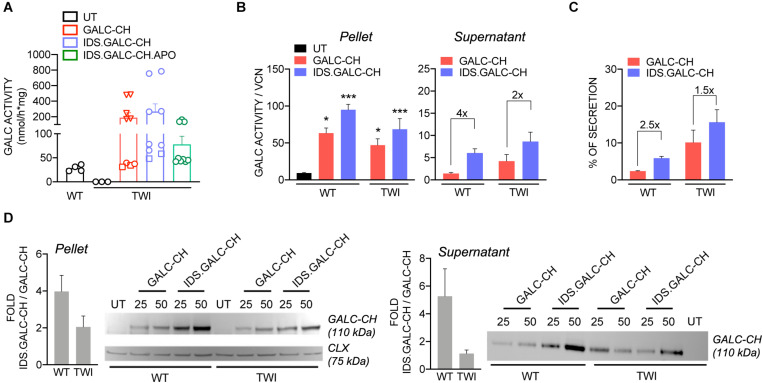
LV-transduced NPCs and progeny express and secrete the chimeric GALC enzymes. (A) GALC activity measured in UT and LV-transduced TWI NPCs and UT WT counterparts. Data are the mean ± SEM, n = 4 independent experiments in duplicate/triplicate. □ 25 MOI; O 50 MOI; ▽ 100 MOI. (B) GALC activity (normalized on VCN) measured in the pellet and supernatant of LV.GALC-CH- and LV.IDS.GALC-CH-transduced WT and TWI NPCs. Data are the mean ± SEM, n = 2 independent experiments in duplicate/triplicate. One Way Anova followed by Dunnet’s multiple comparison test, *p<0.05, ***p<0.001 vs. UT WT. (C) Percentage of GALC secretion, calculated as GALC activity in the supernatant/total GALC activity (pellet+supernatant) ×100 in LV.GALC-CH- and LV.IDS.GALC-CH-transduced WT and TWI NPCs. Data are the mean ± SEM, n = 2 independent experiments in duplicate/triplicate. (D) Representative WB and quantification (performed on n = 4 blots in different experiments) showing the GALC-CH protein (anti-mCherry antibody) in the pellet and supernatant of WT and TWI NPCs transduced with LV.GALC-CH and LV.IDS.GALC-CH at 25 and 50 MOI. The observed band of 110 kDa indicates the expression of the precursor GALC protein (80 kDa) fused with the mCherry protein (30 kDa). Calnexin (CLX) was used as normalizer (pellet). UT WT and TWI NPCs serve as controls. Data in the graphs are expressed as FOLD: IDS (mCherry/CLX/VCN)/CH (mCherry/CLX/VCN) (pellet) and IDS (mCherry/VCN)/ CH (mCherry/VCN) (supernatant).